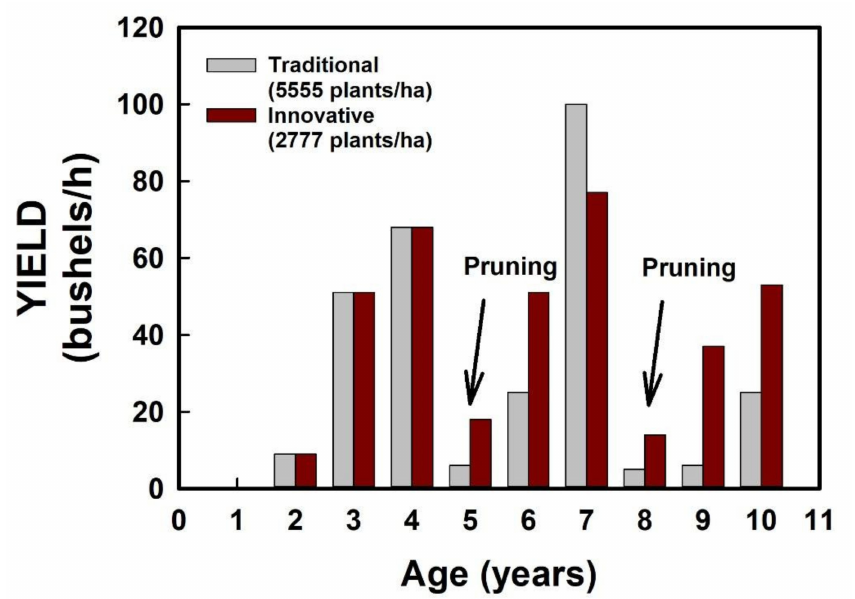
Figure 6. Yields of conventional (5555 plants/h) and innovative (2777 plants/h) sun-exposed coffee fields at La Hilda. Two production systems are shown for a period of eleven years. The arrows indicate pruning of fields. The first and second pruning events occurred in years 5 and 8,